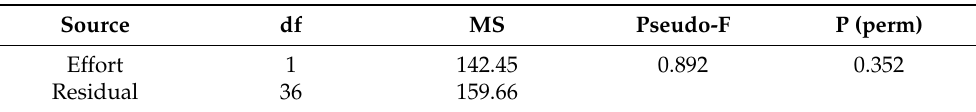
Table 1. PERMANOVA results on the survival of cuttings of the two restoration efforts after one year to